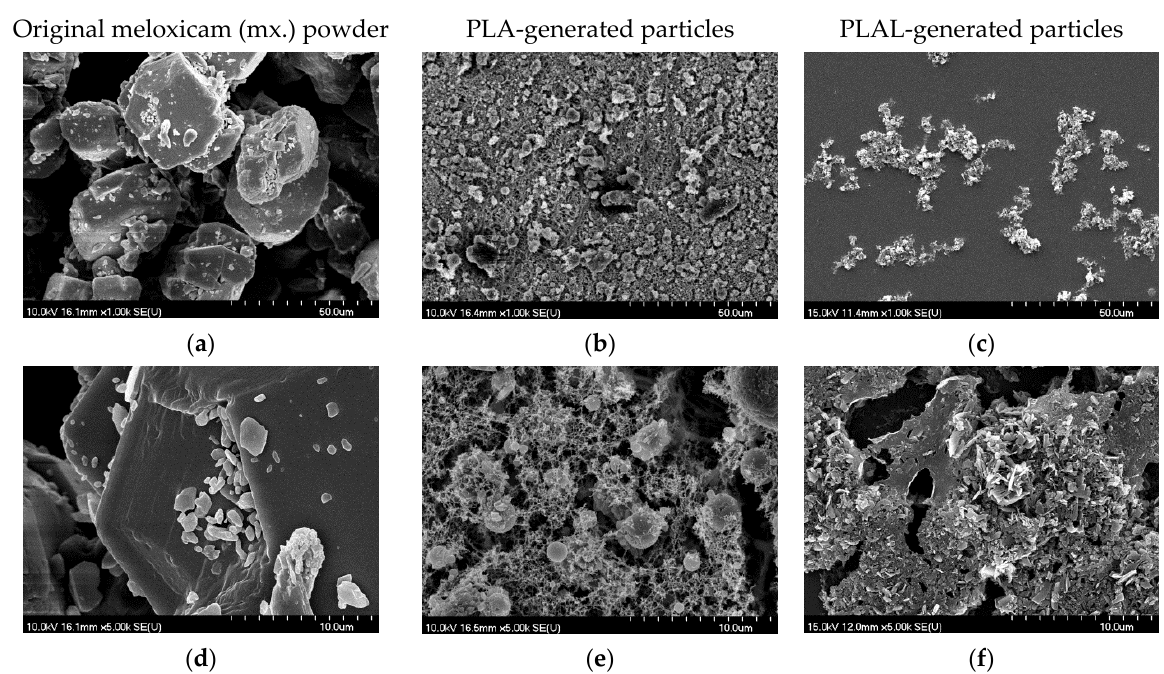
Figure 5. Scanning electron microscopy (SEM) pictures of ( a , d ) the original meloxicam powder, ( b , e ) the PLA-generated particles collected on a teflon filter and ( c , f ) the PLAL-generated particles placed on a silicon plate. Magnification was 1k and 5k in the upper ( a–c ) and lower ( d–f ) row, respectively.